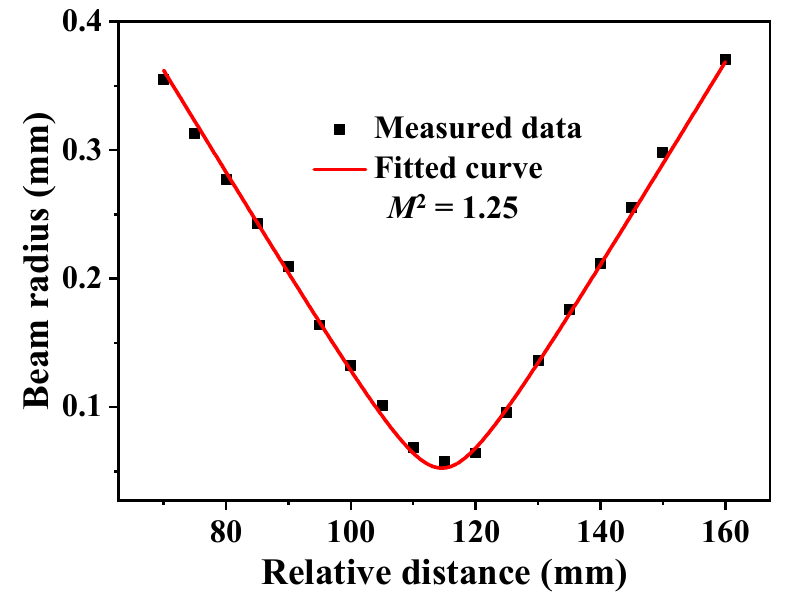
Figure 6. Beam quality of the Q-switched Nd:YAG laser.